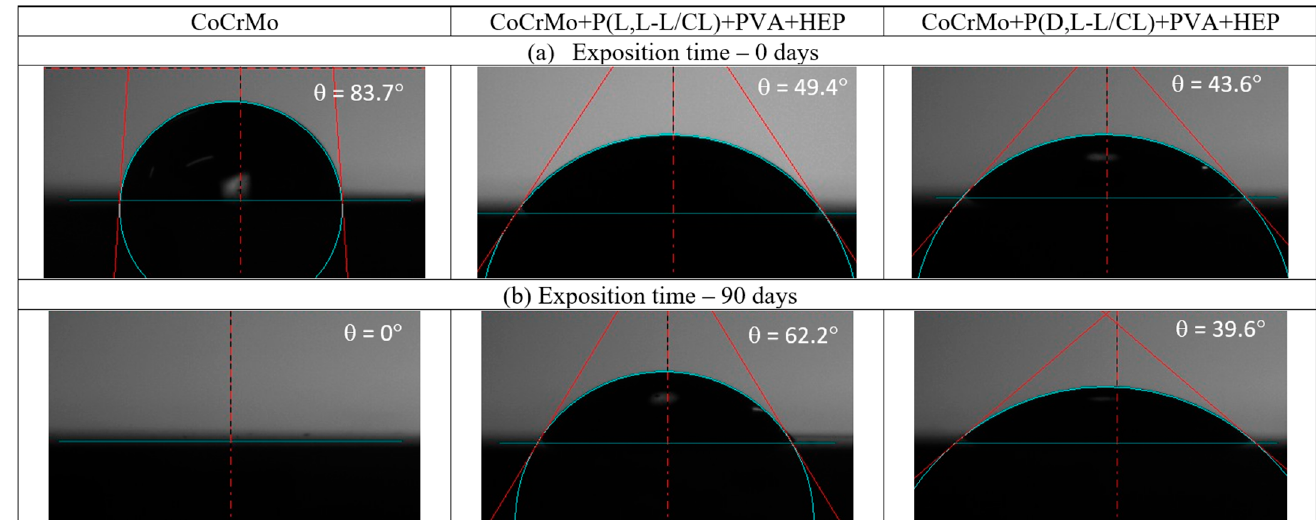
Figure 3. Exemplary figure of the drops during the wettability test. ( a ) Initial state (0 days of exposition); ( b ) after 90 days of exposition in artificial urine.